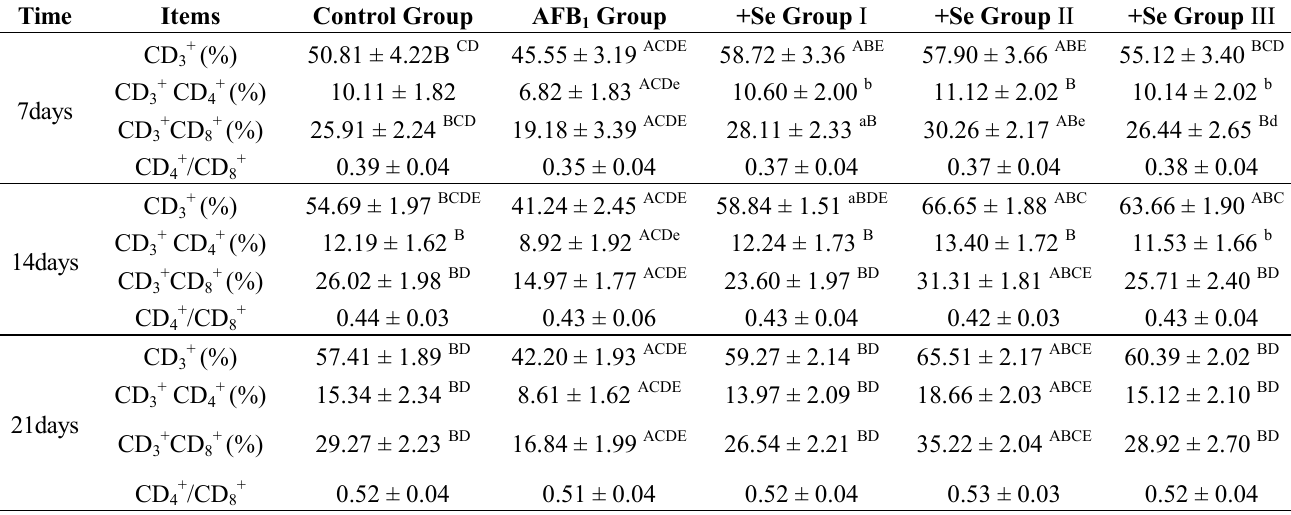
Table 3. Changes of splenic T cell